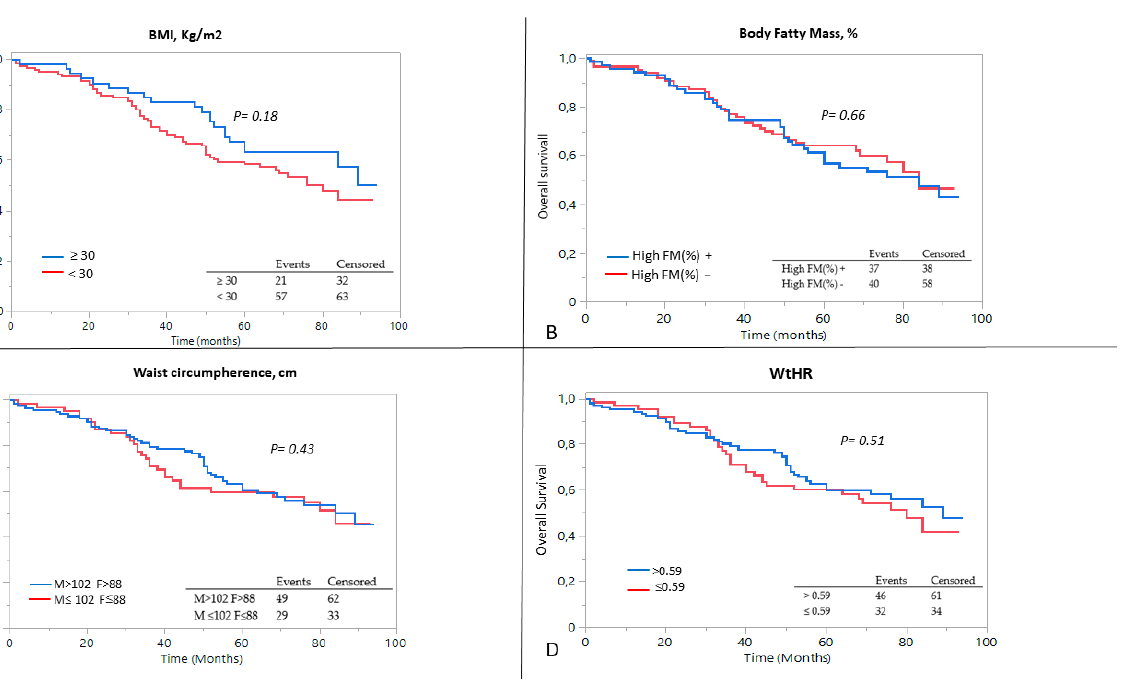
Figure 2. Kaplan–Meier curves for kidney outcome (ESKD) after dividing the patients on the basis of ( A ) BMI, ( B ) percentage of body fat mass, ( C ) waist circumference and ( D ) waist-to-height ratio. A log-rank analysis was conducted.